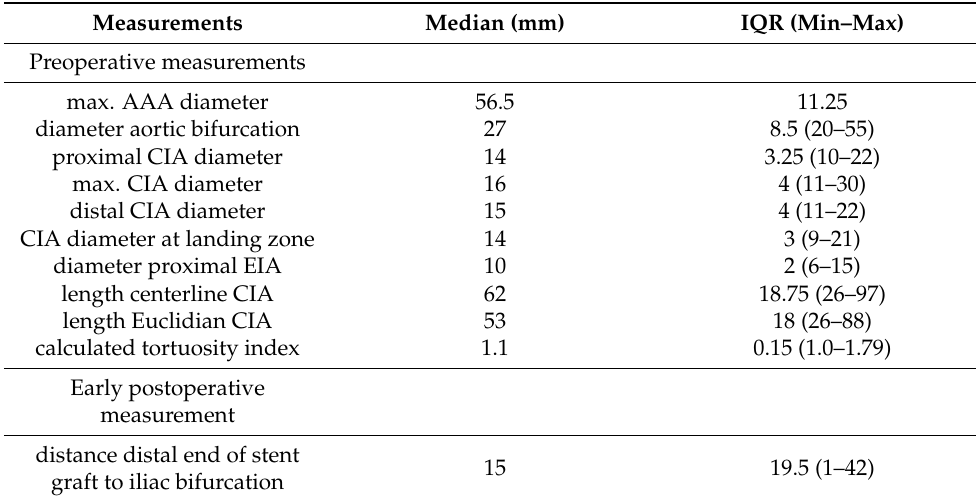
Table 1. Baseline